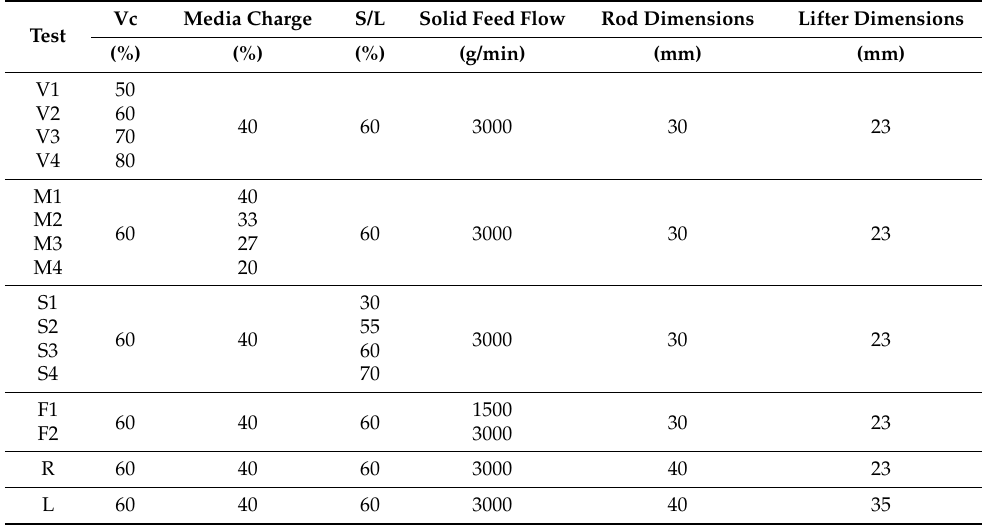
Table 4. Experimental design of the rod mill experiments for product control study. Vc is the critical rotational speed of the mill. The tests are grouped into six categories, where V changes Vc, M changes media charge percentage, S changes solid/liquid ratio, F changes solid feed flow, R changes rod diameter, and L changes lifter